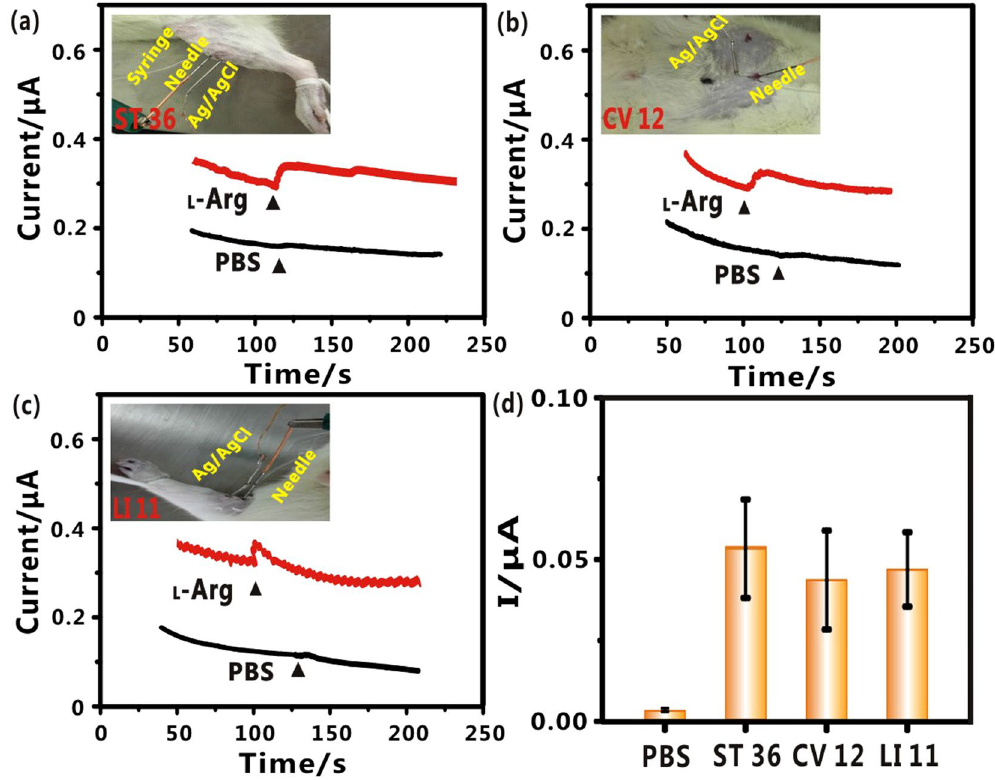
Figure 5. Real-time monitoring of NO in different acupoints by the FGPC modified needle: ( a ) Amperometric response of FGPC/AN to NO stimulated by L -Arg (red line) and PBS (black line) in ST36. Inset: Optical image of in vivo measurement. ( b ) Amperometric response of FGPC/AN to NO stimulated by L -Arg (red line) and PBS (black line) in LI11. Inset: Optical image of in vivo measurement. ( c ) Amperometric response of FGPC/AN to NO stimulated by L -Arg (red line) and PBS (black line) in CV12. Inset: Optical image of in vivo measurement. ( d ) Histogram of the corresponding amperometric response of the needle to NO release from different acupoints. Error bars represent standard deviations of measurements (n =